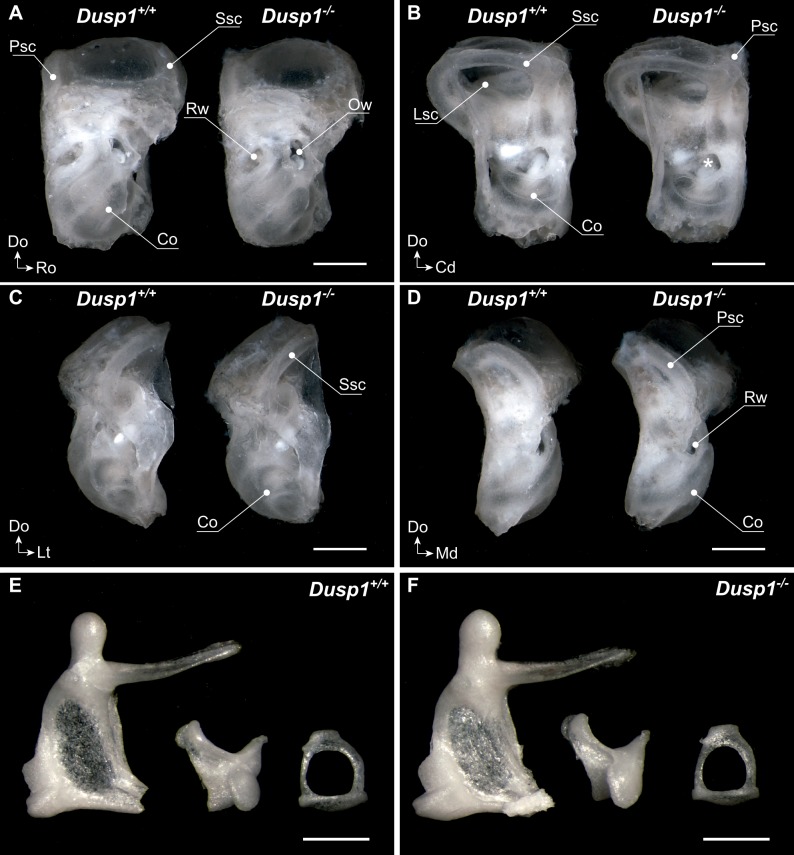
Middle and inner ear morphology of Dusp1+/+ and Dusp1–/– mice.(A–D) Representative images taken after soft tissue cleaning of 2-month-old Dusp1+/+ (n = 4) and Dusp1–/– mice (n = 4). Lateral (A), medial (B), rostral (C) and caudal (D) views. Co, cochlea; Lsc, lateral semicircular canal; Ow, oval window; Pscl, posterior semicircular canal; Rw, round window; Ssc, superior semicircular canal . (E–F) Representative images of the middle ear ossicles of Dusp1+/+ (n = 4) (E) and Dusp1–/– (n = 4) (F) mice. Malleus (left), incus (center) and stapes (right) at 2 months of age. Scale bars: (A–D), 1 mm,;(E–F), 500 μm.